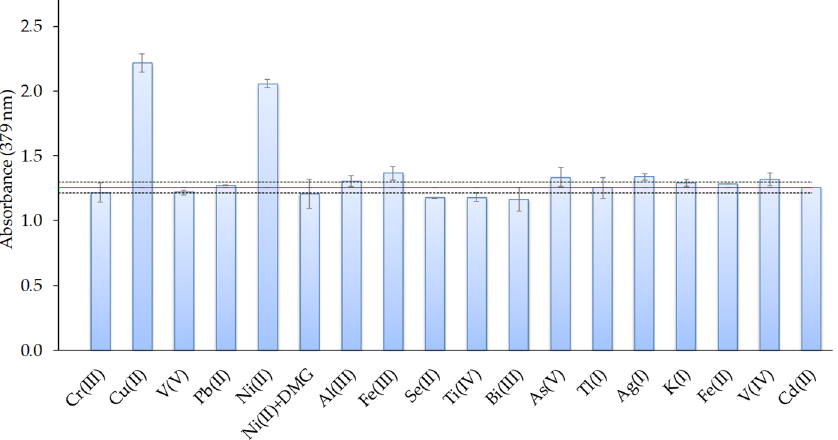
Figure 9. Effect of the presence of different metal ions on the response of the optical sensor for a 1:1 Cd(II): interfering metal ratio (metal concentrations: 0.4 mg L − 1 ; n = 2).